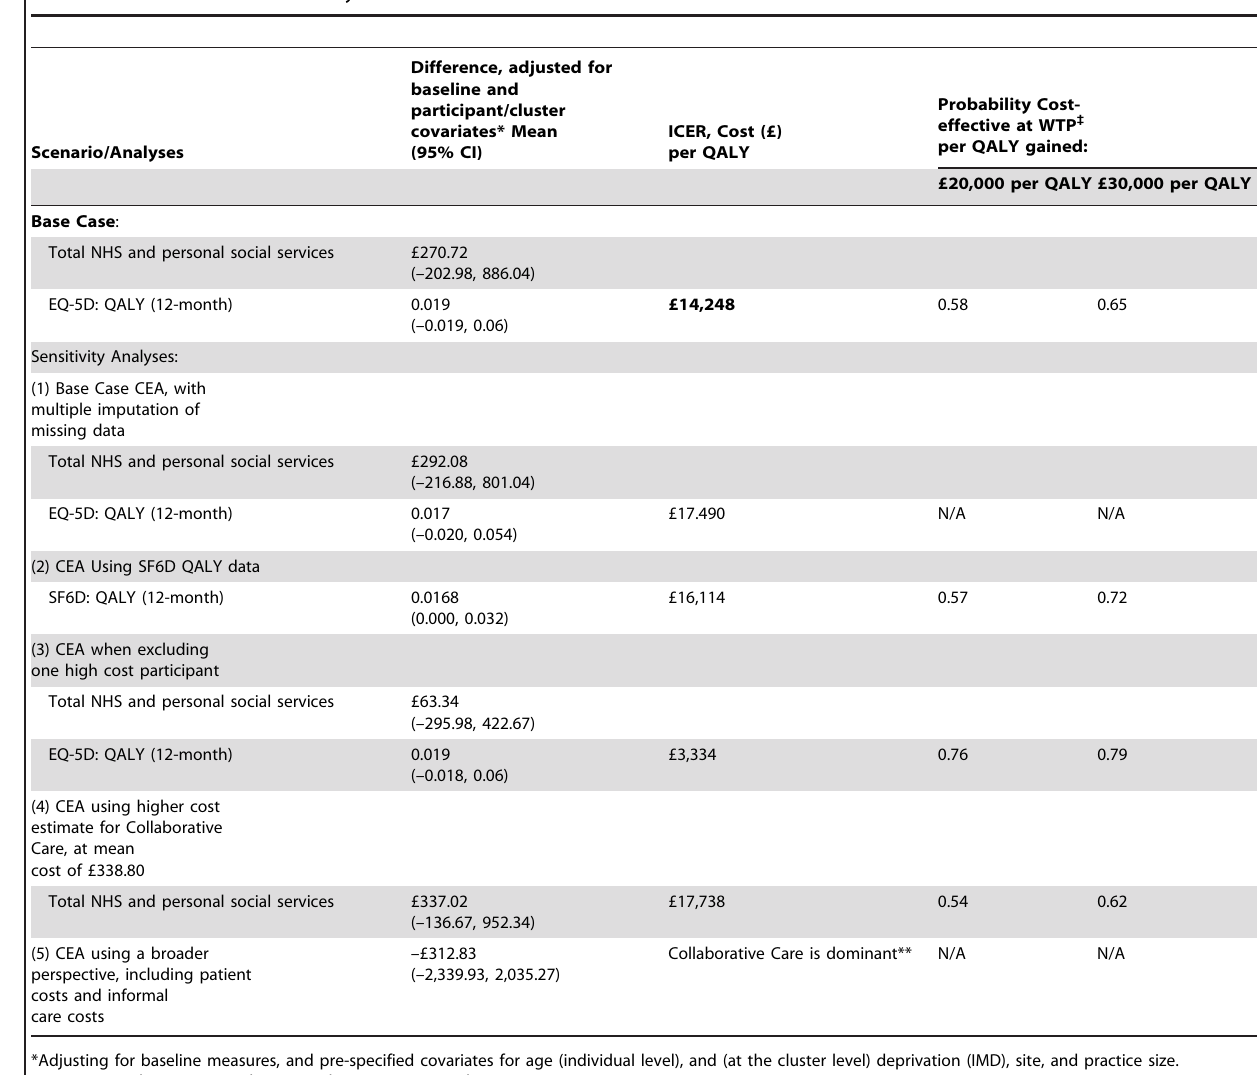
Table 6. Cost Effectiveness